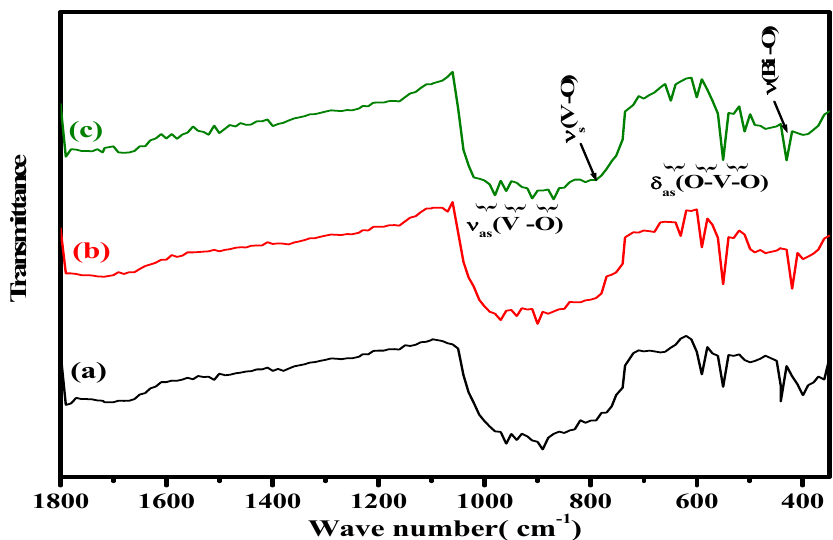
Figure 3. FTIR spectra of BiFeVOx.y for ( a ) y = 0.03, ( b ) y = 0.07, and ( c ) y = 0.15.